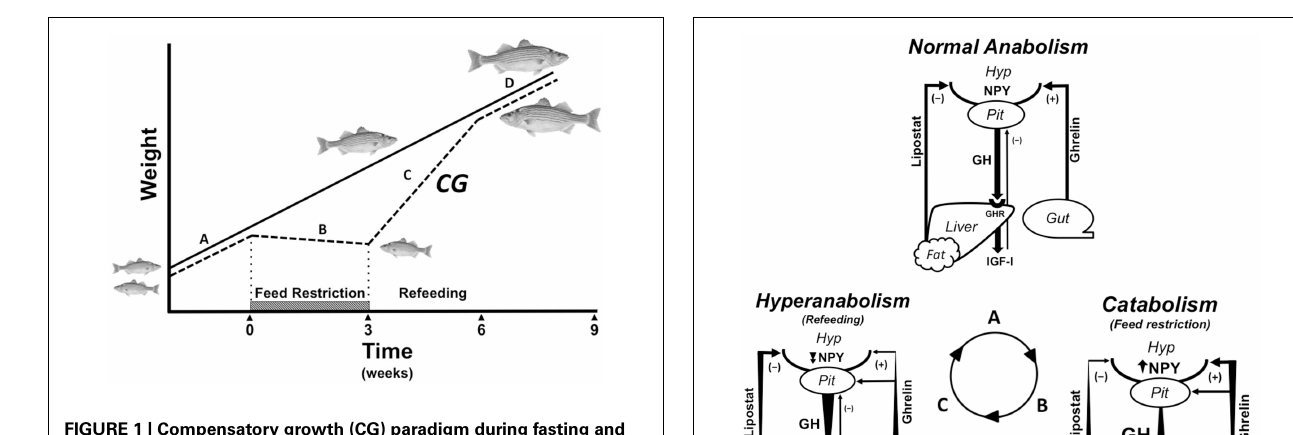
FIGURE 1 | Compensatory growth (CG) paradigm during fasting and refeeding (dashed line) compared to constant growth rate in fed controls (solid line) . Normal growth (A) is disrupted by feed restriction (hatched bar), which results in a decline in the growth trajectory (B) and a size disparity compared to control animals fed a constant regimen.When feeding resumes, hyperphagia and enhanced growth axis activity drive a hyperanabolic phase (C) marked by a steeper growth curve than that of constantly fed animals.The CG response potentially allows stunted animals to fully compensate for lost growth opportunity and re-converge in size with constantly fed controls before the growth rate returns to normal (D) .